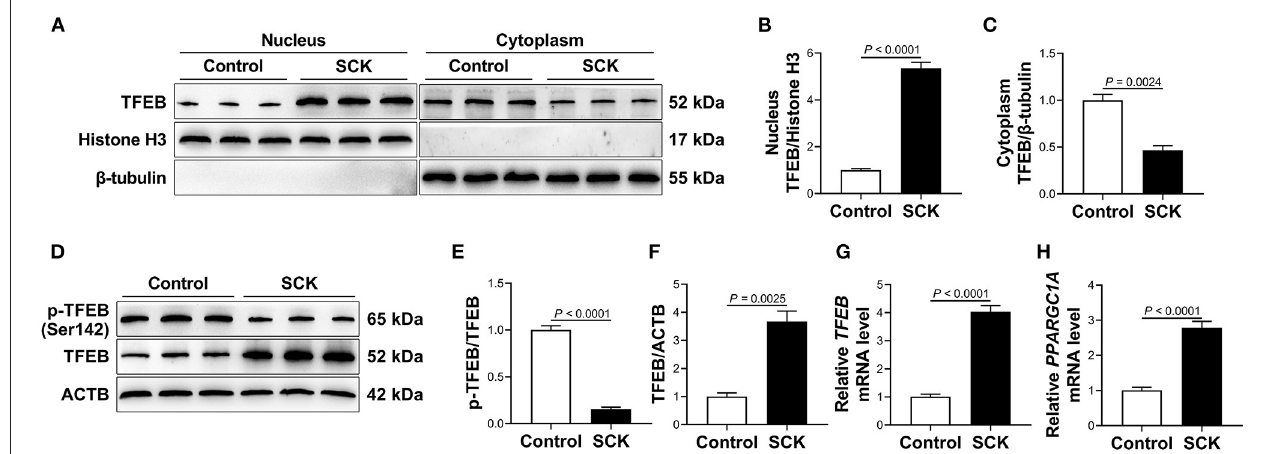
FIGURE 1 | Transcriptional activity of transcription factor EB (TFEB) in white adipose tissue (WAT). (A) Western blot analysis of TFEB in the nucleus and cytoplasm of WAT of control cows ( n = 15) and dairy cows with subclinical ketosis (SCK; n = 15). Representative blots are shown. (B,C) Quantification of protein abundance of nuclear and cytoplasmic TFEB, respectively. (D) Western blot analysis of phosphorylated TFEB (p-TFEB) and total TFEB in WAT of control cows ( n = 15) and dairy cows with SCK ( n = 15). Representative blots are shown. (E,F) Quantification of ratio of p-TFEB/TFEB and protein abundance of TFEB, respectively. (G,H) Relative mRNA abundance of TFEB and peroxisome proliferator-activated receptor gamma coactivator 1 alpha ( PPARGC1A ) in WAT of control cows ( n = 15) and dairy cows with SCK ( n = 15). Data were analyzed using unpaired t -tests and expressed as mean ± SEM.